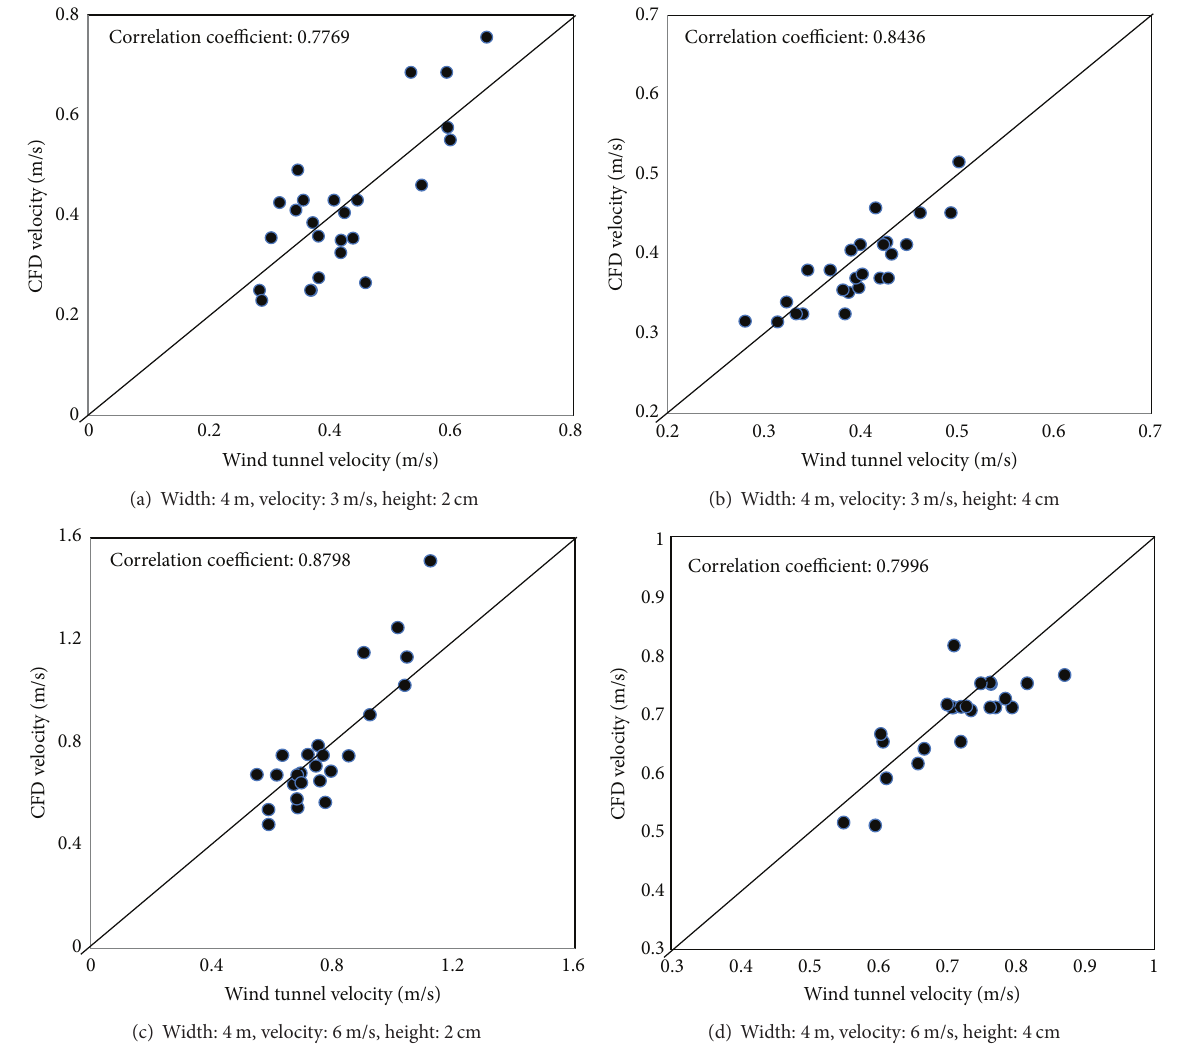
Figure 21: Wind velocity distribution and correlation coefficients for wind tunnel test and CFD.